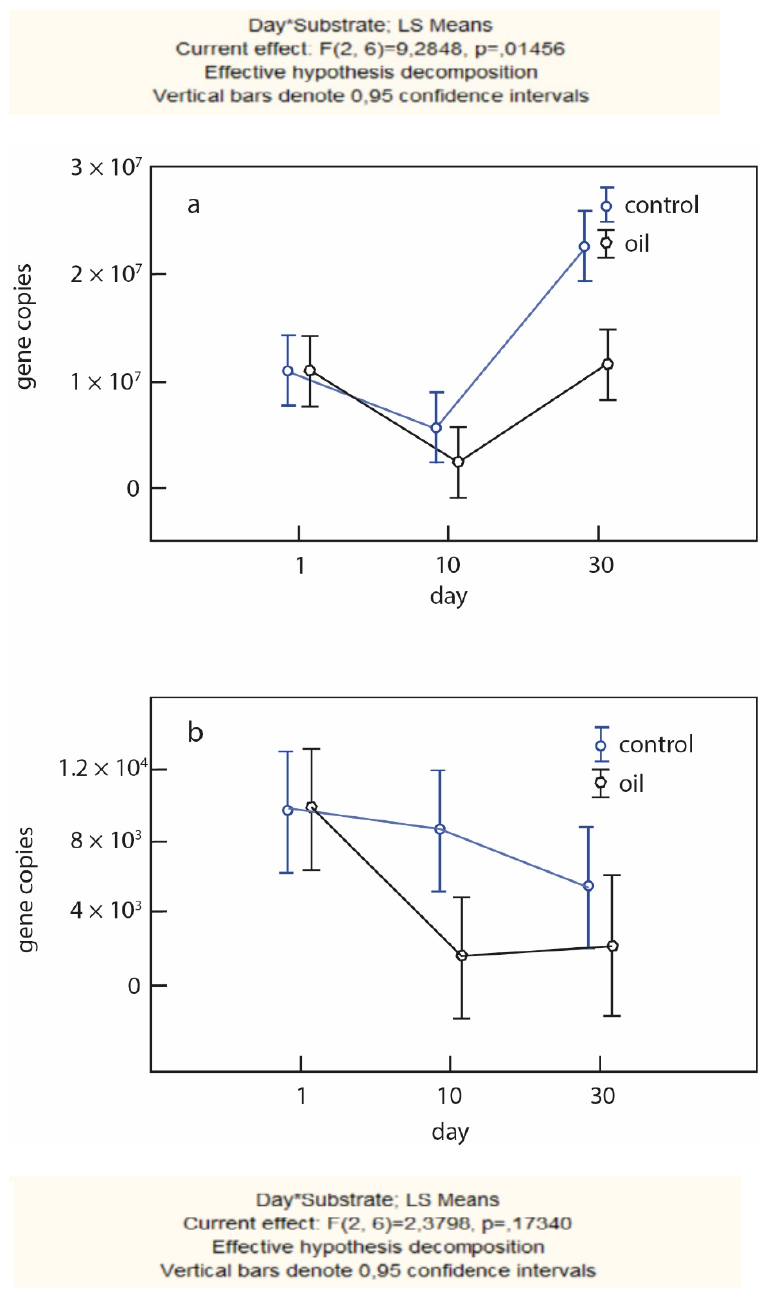
Figure 9. Dynamics of functional amoA genes in volcanic soils (buried horizon): ( a )—bacteria; ( b )—archaea.